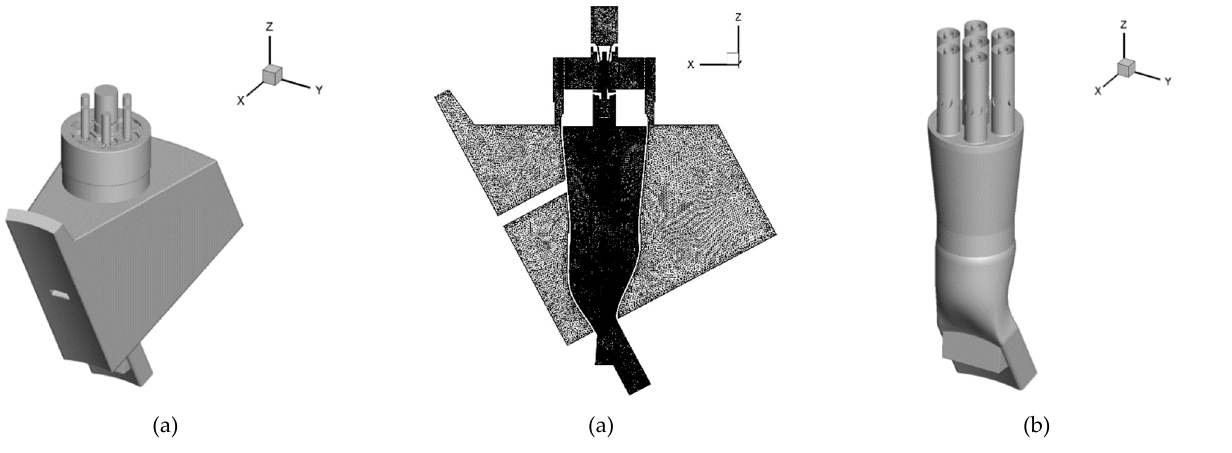
Figure 8. Geometry and mesh of the two models. ( a ) Overall model geometry and mesh; ( b ) Partial model geometry.